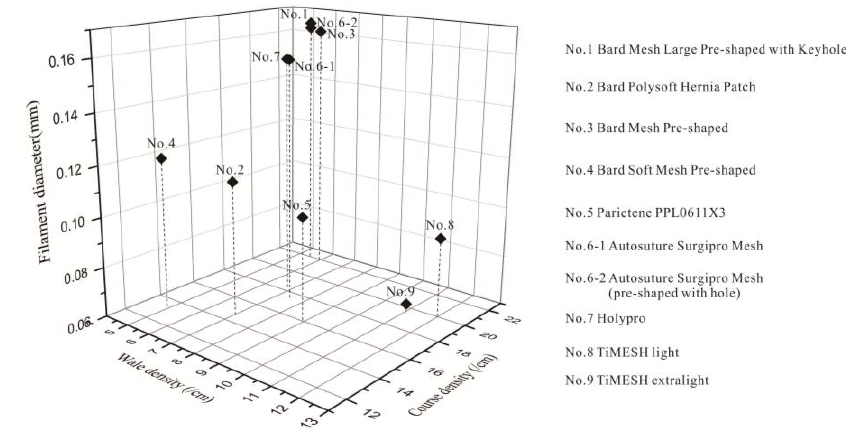
Figure 4. Relationship between filament diameter and stitch density of hernia prostheses.